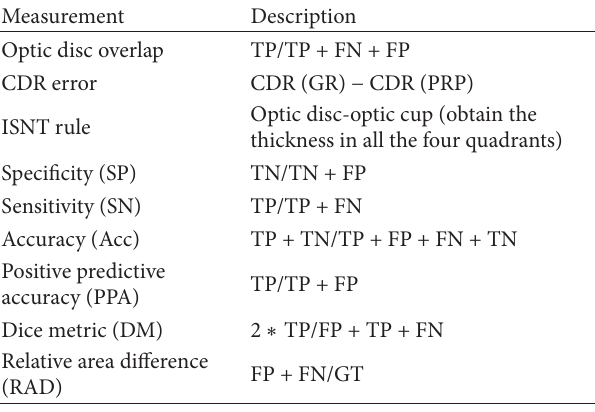
Table 1: Performance metrics for optic disc and optic cup segmen- tation.